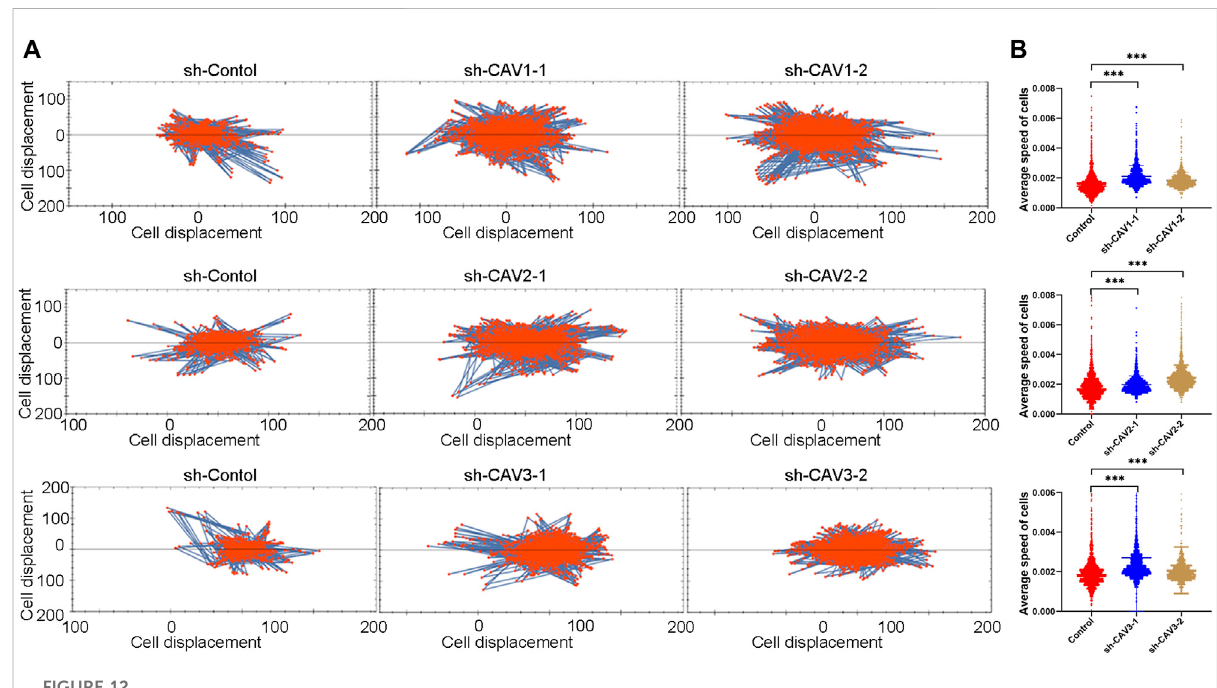
FIGURE 12 Cell motility was monitored in real time by The High-Throughput Connotation of Imaging System. (A) CAV knockdown increased the cumulative displacement (B) and increased the mean rate of motion of indicated cells. * p < 0.05, ** p < 0.01, *** p <